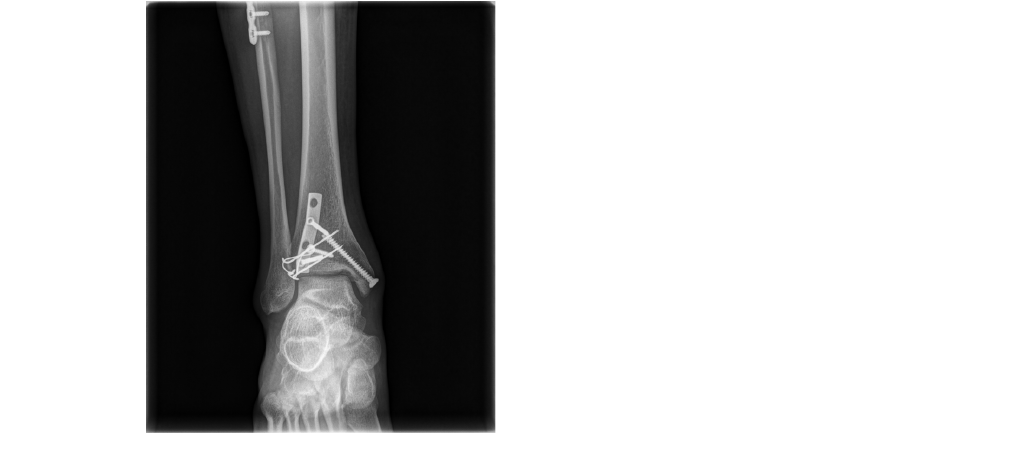
Figure 4. A postoperative, plain anteroposterior radiograph shows a Chaput fracture fixed using the new technique.